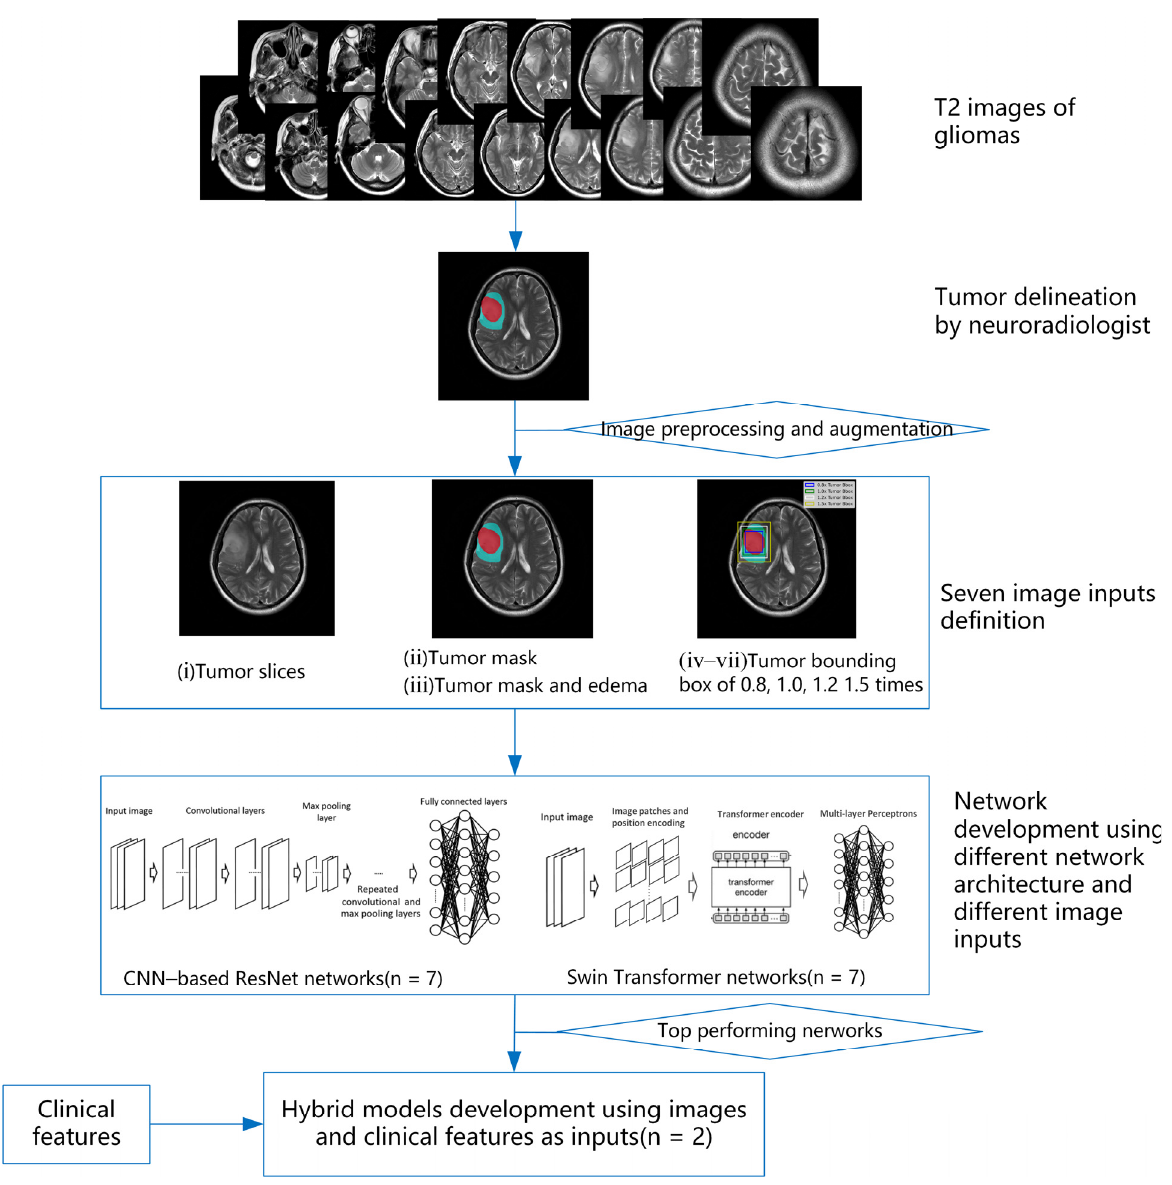
Figure 2. Overview of this study design. This study includes five key steps: tumor delineation, im- age preprocessing and augmentation, image inputs definition, network development, and hybrid model